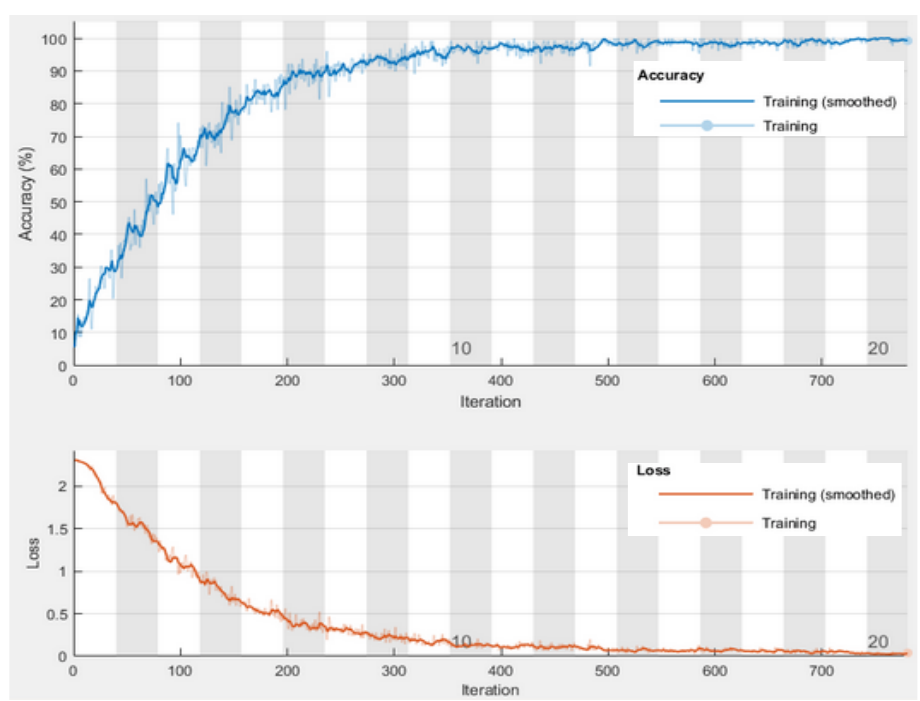
Figure 6. Accuracy and loss curves of the proposed approach.